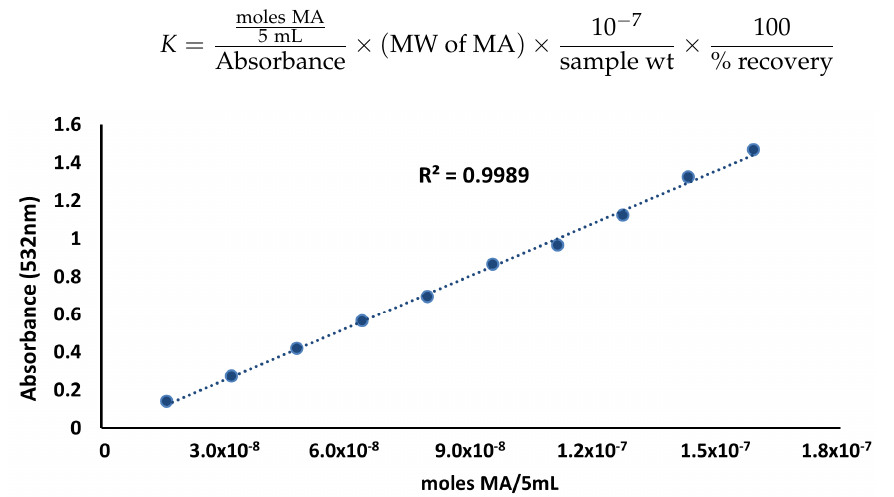
Figure 1. Standard curve of malonaldehyde for the steam distillation TBA method. The lipid oxidation of various food samples was measured using steam